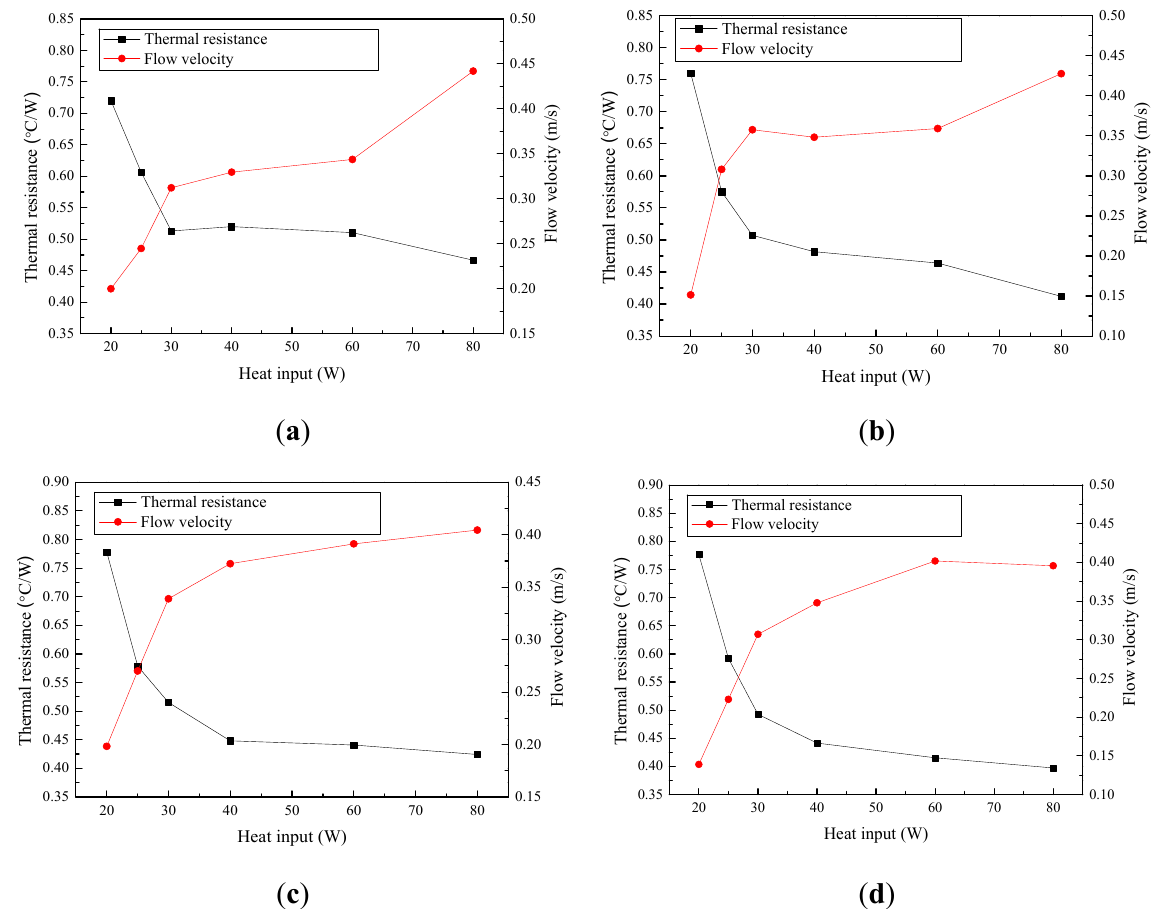
Figure 10. The thermal resistances and the flow velocities for the PHP with the adiabatic length of ( a ) 60 mm, ( b ) 120 mm, ( c ) 180 mm and ( d ) 240 mm.